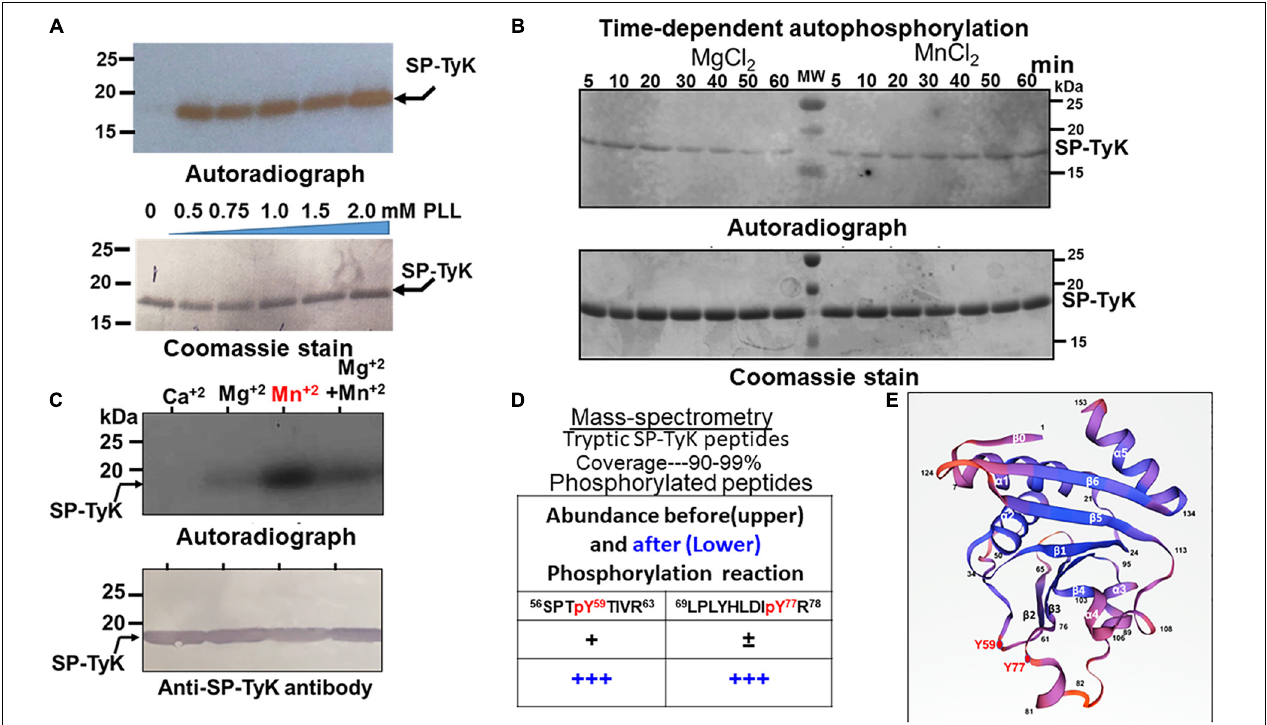
FIGURE 2 | Autophosphorylating properties of Spy_1476. (A) Autoradiograph showing 32 P-ATP –based autophosphorylation of the Ni-NTA affinity-purified recombinant 6XHis Spy_1476 (SP-TyK) carried out in the presence and absence of different concentrations of poly– L -lysine. (B) Poly- L -lysine and 32 P-ATP -based autophosphorylation reaction in the presence and absence of 5 mM MgCl 2 or MnCl 2 at different time-points up to 60 min. Time-dependent phosphorylation reaction denotes MnCl 2 as a preferred divalent cation cofactor and 60 min as the optimal incubation time. (C) The efficiency of autophosphorylation reactions in the presence of different cations employing an optimal reaction condition as described in panel (B) . In panels (A–C) , the upper panels denote autoradiographs, and except in panel (C) , the lower panels are the corresponding Coomassie-stained gel serving as loading controls. The lower panel in panel (C) is the corresponding Western immunoblot of the upper panel stained with Protein-A column purified Anti-SP-TyK rabbit polyclonal IgG and corresponding Alk-phosphatase-labeled conjugate antibody as visualized by using a colorimetric substrate. (D) Mass-spectrometric analysis of the tryptic peptides of in vitro autophosphorylated and non-phosphorylated Spy_1476. “ ± ” and “ +” indicate low abundance of phosphorylation as revealed by the manual examination of phosphorylated residues ( > 50 scores and p > 0.05). Residues in the red font denote phosphorylated residues (Tyr59 and Tyr77). (E) Three dimension structures of Streptococcus pyogenes -tyrosine kinase (SP-TyK) based on H. influenzae YjeE using SWISS port (PDB:1FL9) (Teplyakov et al., 2002). The structure shows seven stranded mixed β -sheet in the following order of residues: 1-5 β 0 → 7-18 α 1 → 25-30 β 1 → 37-48 α 2 → (Y59)-61-65 β 2 → 71-75 β 3-(Y77) → 78-80 α 3 → 89-92 α 4 → 97-101 β 4 → 103-110 α 5 → 114-121 β 5 → 126-133 β 6 → 135-147 α 6. The phosphorylated Y59 and Y77 residues near the two adjacent loops (beginning of β 2 and end of the β 3 sheets) are highlighted with red closed